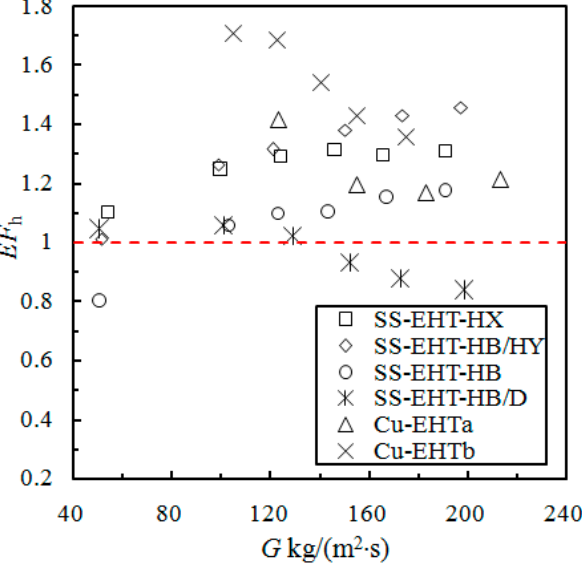
Figure 5. Comparison of the evaporation heat transfer enhancement factors (EF) for the enhanced tubes from this study.